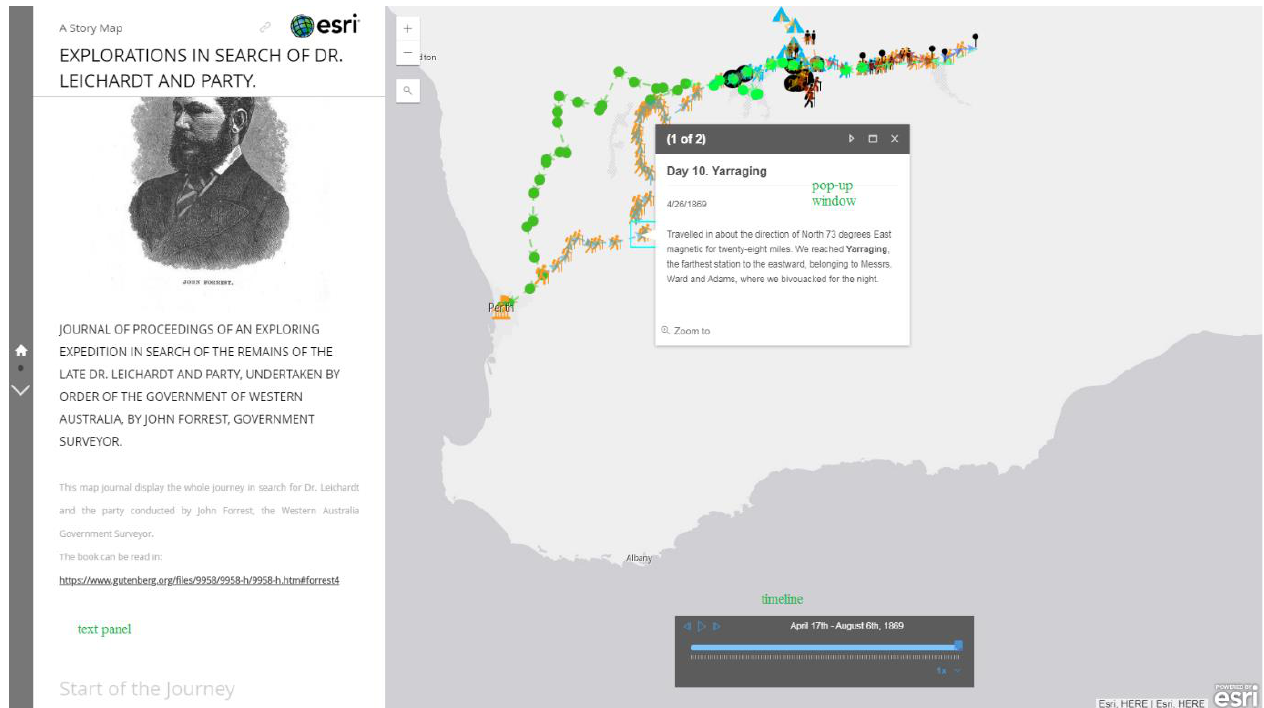
Figure 6. Interactive map built with Story Map Journal.